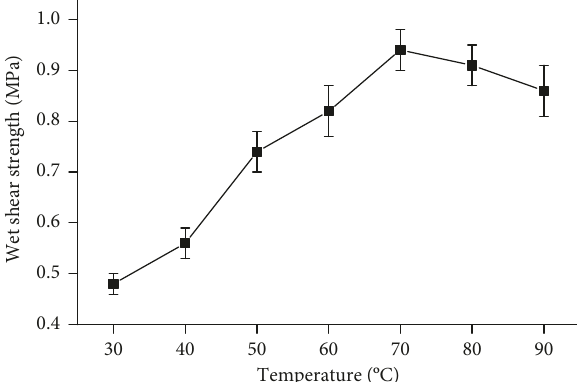
Figure 3: Effects of reaction temperature on wet shear